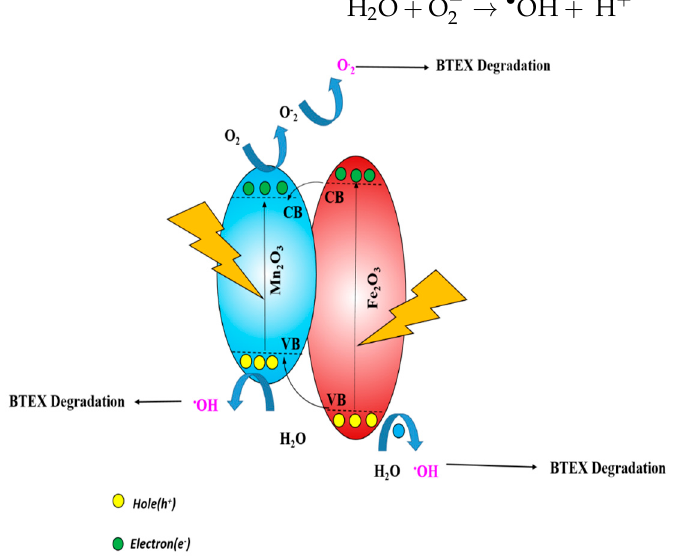
Figure 13. The degradation mechanism of BTEX on the surface of Fe 2 O 3 -Mn 2 O 3 /SiO 2.